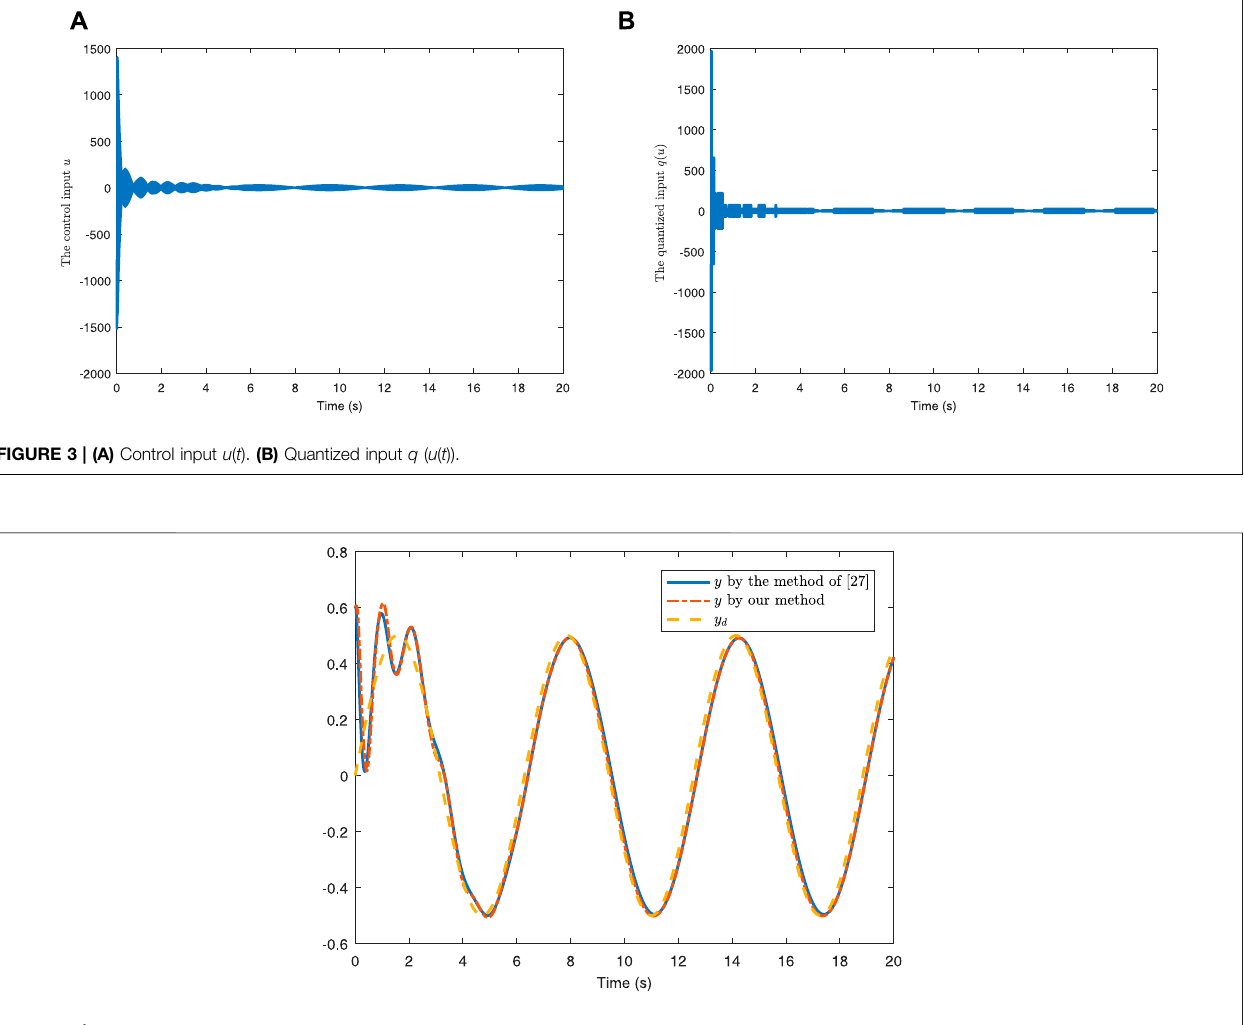
FIGURE 4 | Comparative results between our approach and the method proposed by [24].